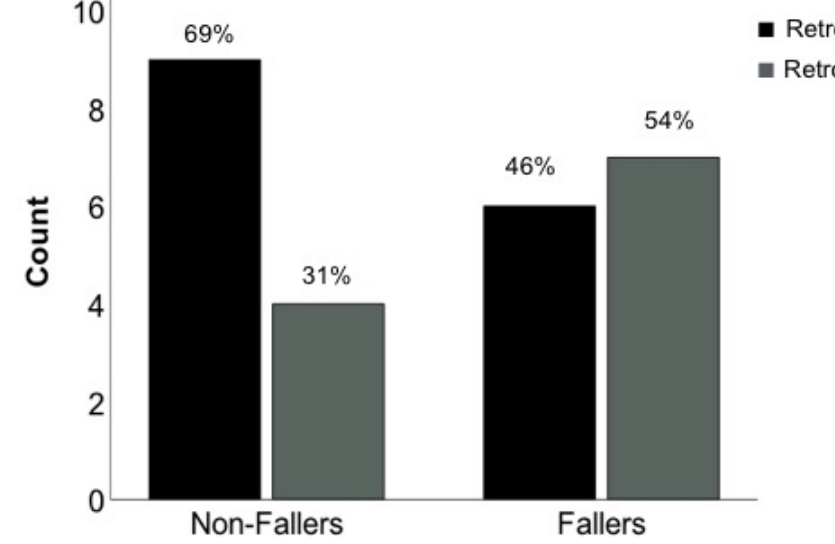
Figure 2. Percent of non-fallers and fallers predicted by retrospective fall history of 1 year. Final prediction model based on fall history and daily mobility measures (multivariate model): When the instrumented gait measures discriminative of fallers from non-fallers (pitch at toe-off (°), gait speed (m/s), stride length (m), double-support (%), swing (%), pitch at initial contact (°), turn angle (°)) were entered along with the history of falls in the prediction model, a forward regression yielded a significant model consisting of only one gait variable, foot pitch at toe-off ( p < 0.01). The discriminative ability of the final model to classify future fallers from non-fallers with the pitch at toe-off angle as a predictor was 86% (AUC = 0.86, p < 0.002, Figure 3).